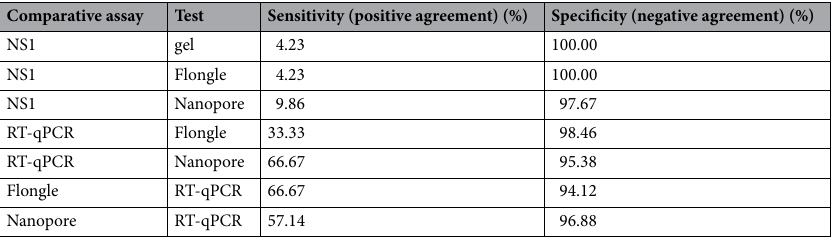
Table 3. Sensitivity and specificity of clinical